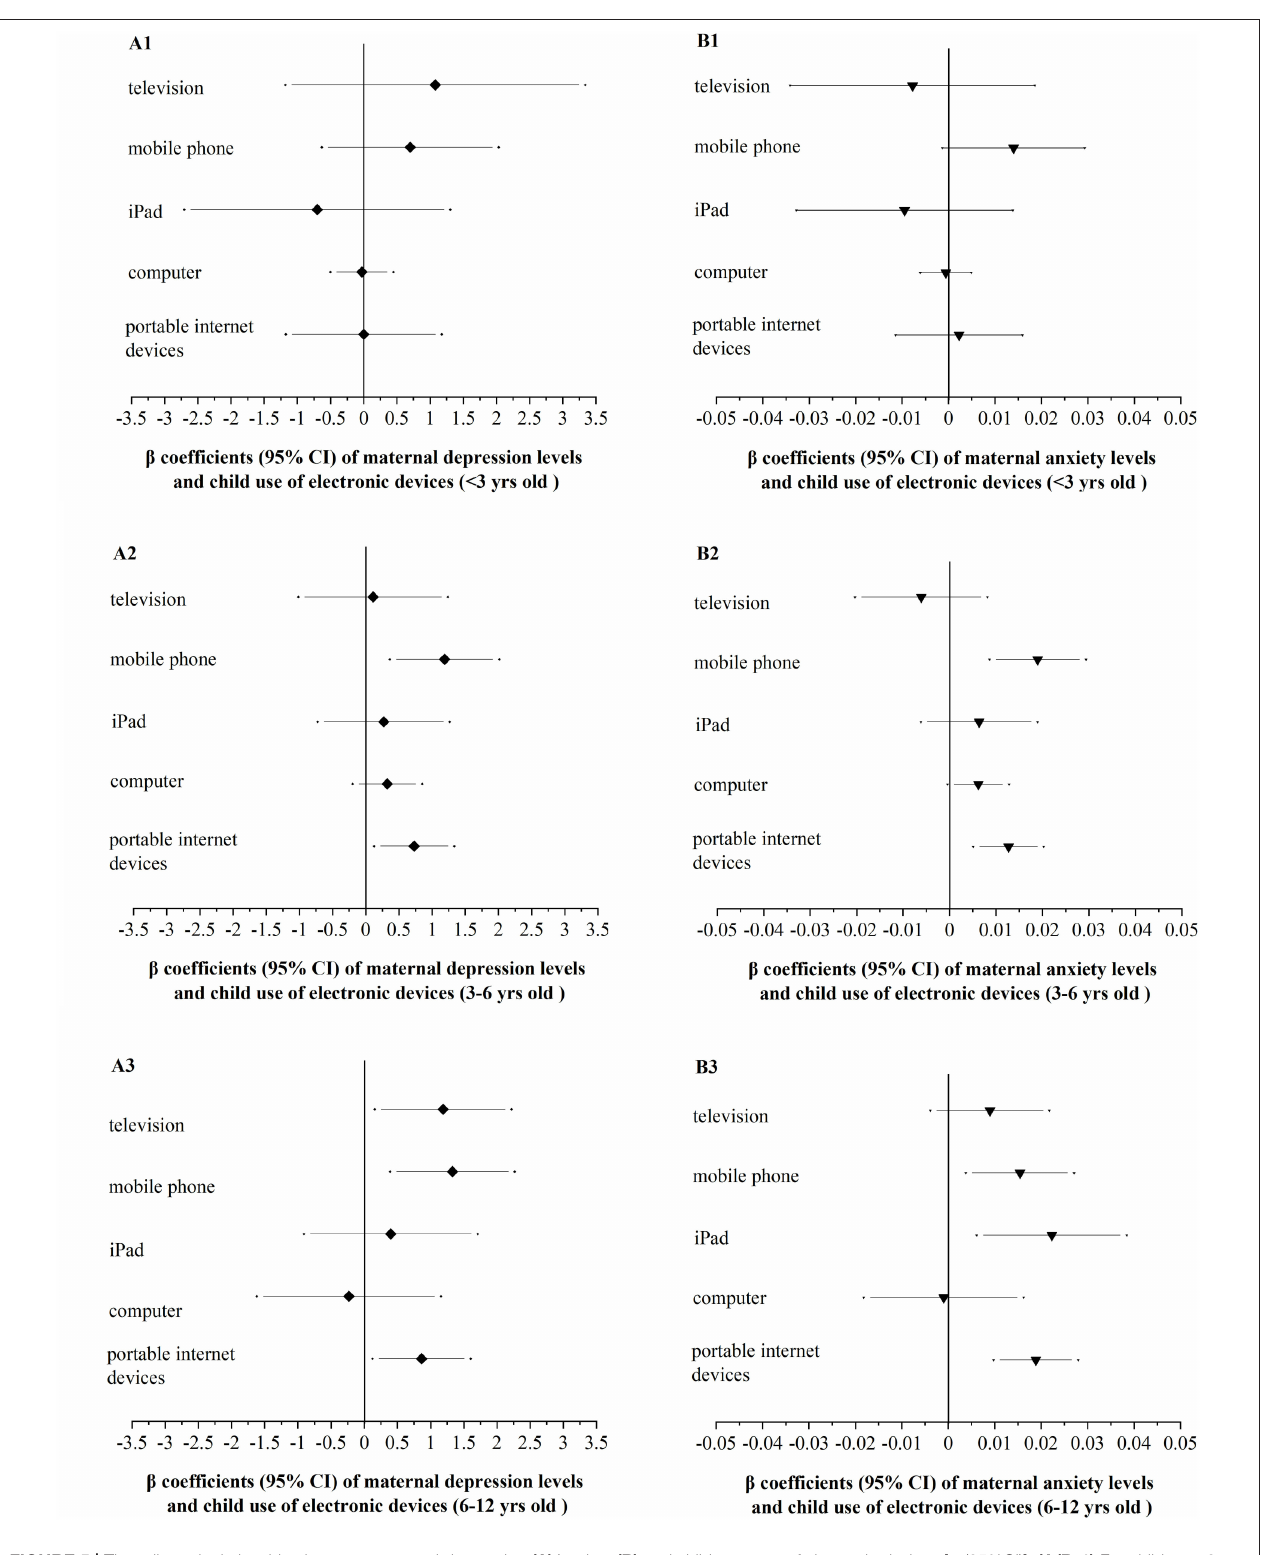
FIGURE 5 | The adjusted relationships between maternal depression (A) /anxiety (B) and child over-use of electronic devices [ β (95%CI)]. (A/B-1) For children < 3 years old; (A/B-2) for children of 3–6 years old; (A/B-3) for children of 6–12 years old. Adjusted for child age, child gender, maternal age, maternal educational background, family structure, and home